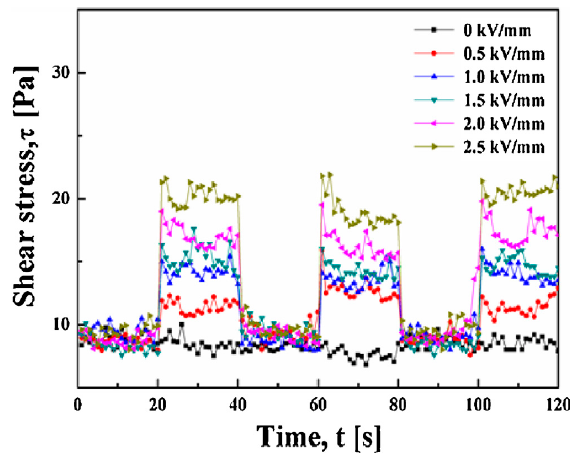
Figure 11. Shear stress vs. time at a set shear rate (1/s) for a 0.5 vol % cellulose carbamate (CC) based ER fluid under a series of external electric field strengths (reprinted from [46]).